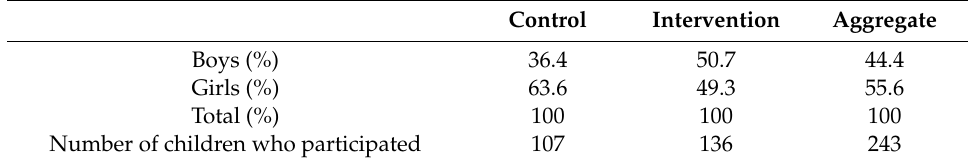
Table 2. Gender balance of the sampled children.